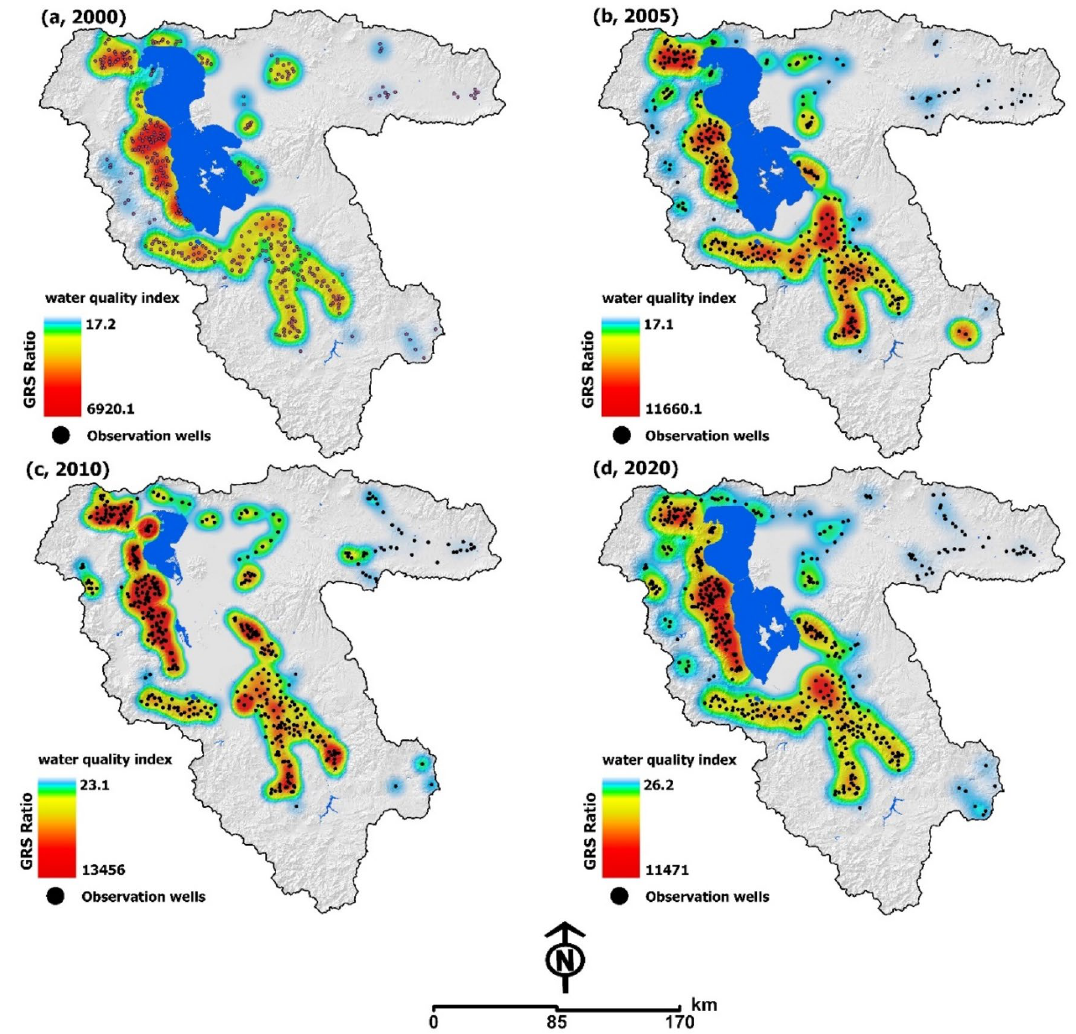
Figure 5. Results of monitoring the trend of groundwater resources salinization (GRS) and the way it has spread to the farmlands (red colors) due to the over discharge of aquifers. Figure created in Arc GIS 10.7, ESRI, https:// www. esri.